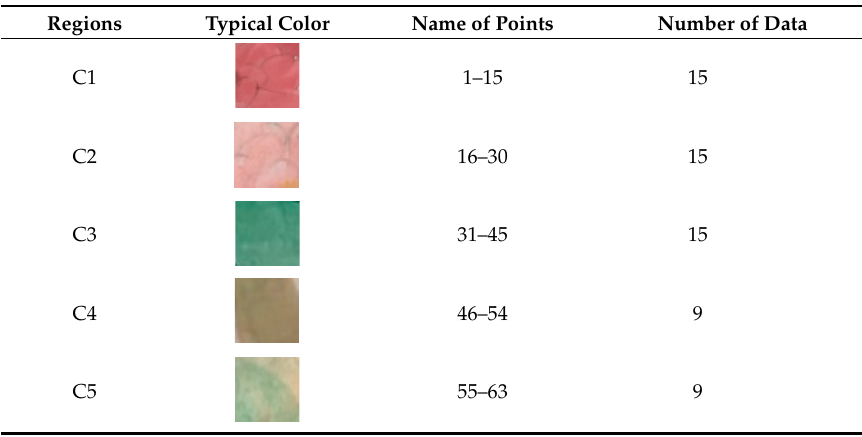
Figure 6. The grid and sample points on surface of the Chinese painting. Table 4. The five regions of the Chinese painting.